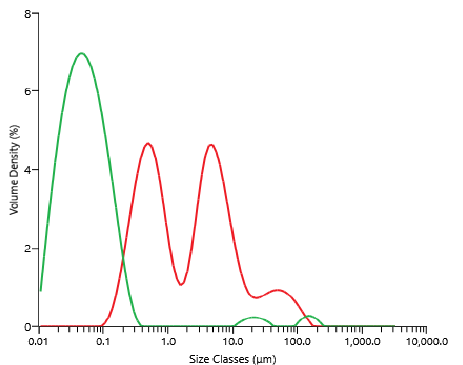
Figure 3. Volume percentage as a function of particle size for the supernatant obtained after centrifugation and freezing/thawing equation before microfiltration (red), and the permeate obtained after microfiltration (green).